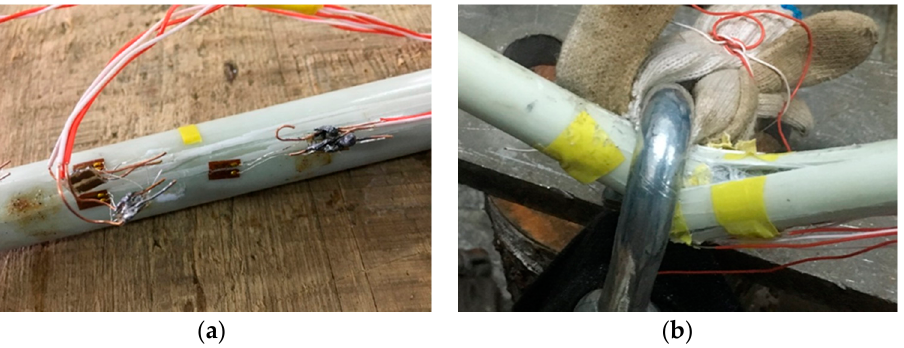
Figure 5. Bending failure modes: ( a ) Failure occurred during static flexural test; ( b ) Failure of HFRP bars occurred as a result of suspending dead loads up to its maximum capacity.